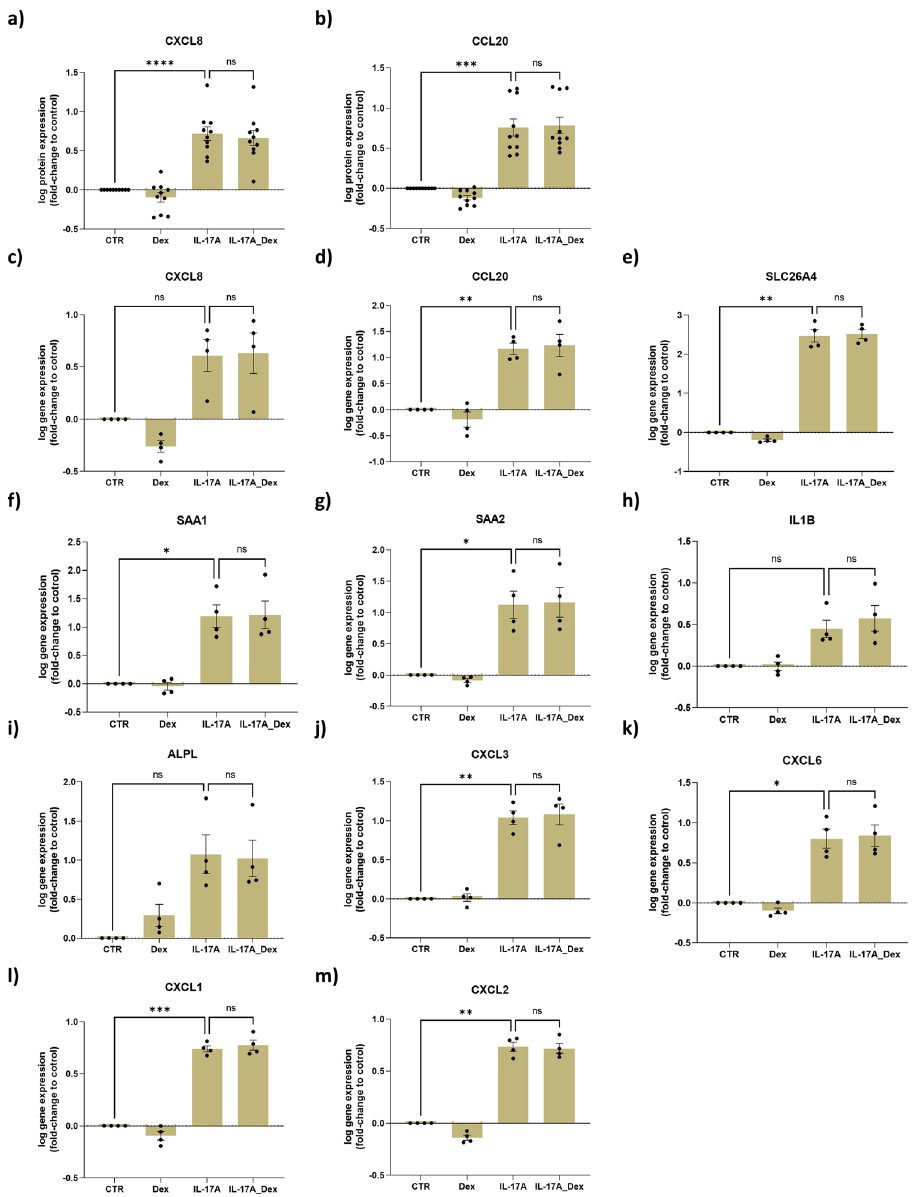
Figure 5. IL-17A stimulates IL-17A gene signature and inflammatory marker expression in human airway epithelial cells (hAECs), and these effects were not prevented by dexamethasone (Dex). hAECs were cultured and differentiated at an air liquid interface (ALI) and exposed to IL-17A (10 ng/ml) with or without dexamethasone (10 nM) for 14 days. CXCL8 and CCL20 protein release was measured by ELISA ( a , b ). CXCL8, CCL20, SLC26A4, SAA1, SAA2, IL1β, ALPL, CXCL3, CXCL6, CXCL1 , and CXCL2 gene expression was determined by total RNA sequencing and normalized gene counts were analyzed. Data represent means ± SEM. N = 10 donors for protein and N = 4 donors for gene expressions analysis. Statistical analyses were performed with paired one-way ANOVA and Tukey’s multiple comparison test, *p < 0.05, **p < 0.01, ***p < 0.001, ****p <